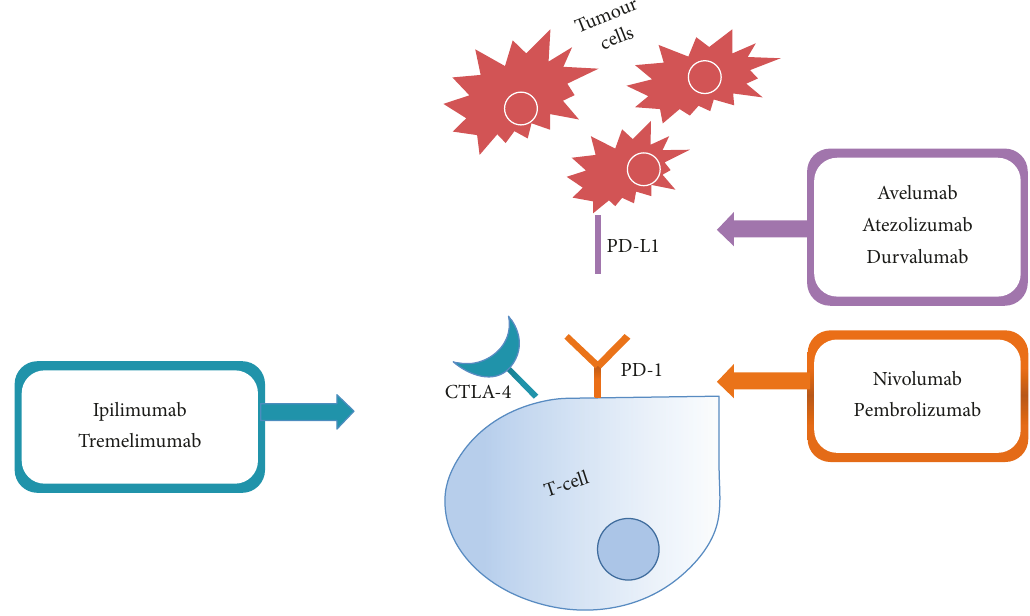
Figure 1: Immune checkpoint blockade with different monoclonal